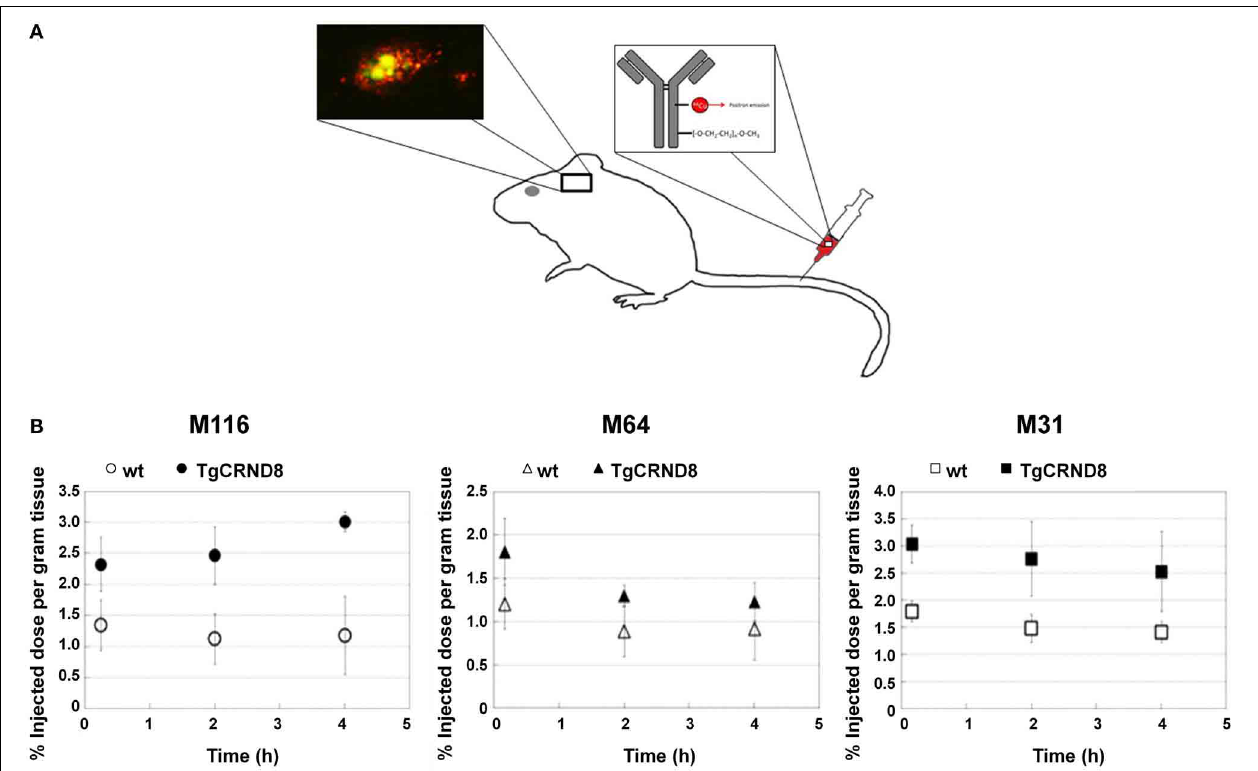
FIGURE 3 | Targeting specific of A β with PET compatible radiolabelled antibodies in the brains of living mice. (A) Antibodies offer an opportunity to image specific types of A β pathology because of their excellent specificity. In the TgCRND8 mouse model of AD, two antibodies, M64 and M116, that target parenchyma aggregated A β plaques and one antibody, M31, that targets vascular A β were tested. All three antibodies were administered i.v. after labeling with both poly(ethylene glycol) (PEG) to enhance circulation and 64 Cu to allow PET plane and exchange with tissue. Control images are required